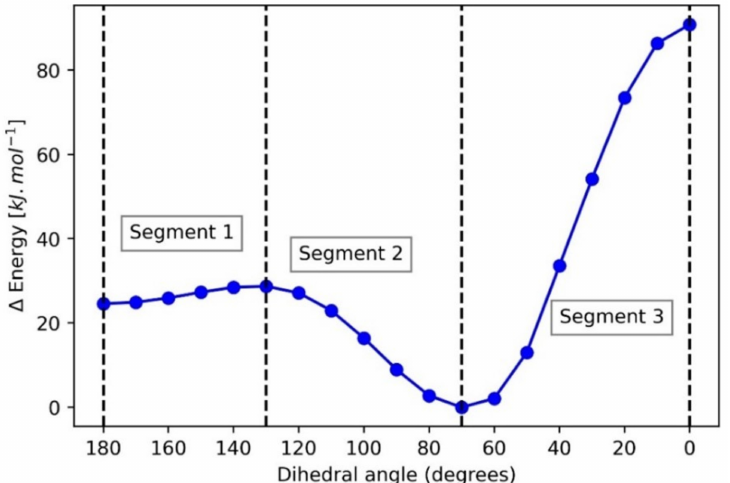
Figure 5. Potential energy surface for DMM as a function of one of the dihedral angles: O5-C1-O4- C10, where tt occurs at 180 ◦ and gg at 70 ◦ . The dashed vertical lines mark the stationary points that divide the energy profile into 3 segments. An REG analysis is performed for each